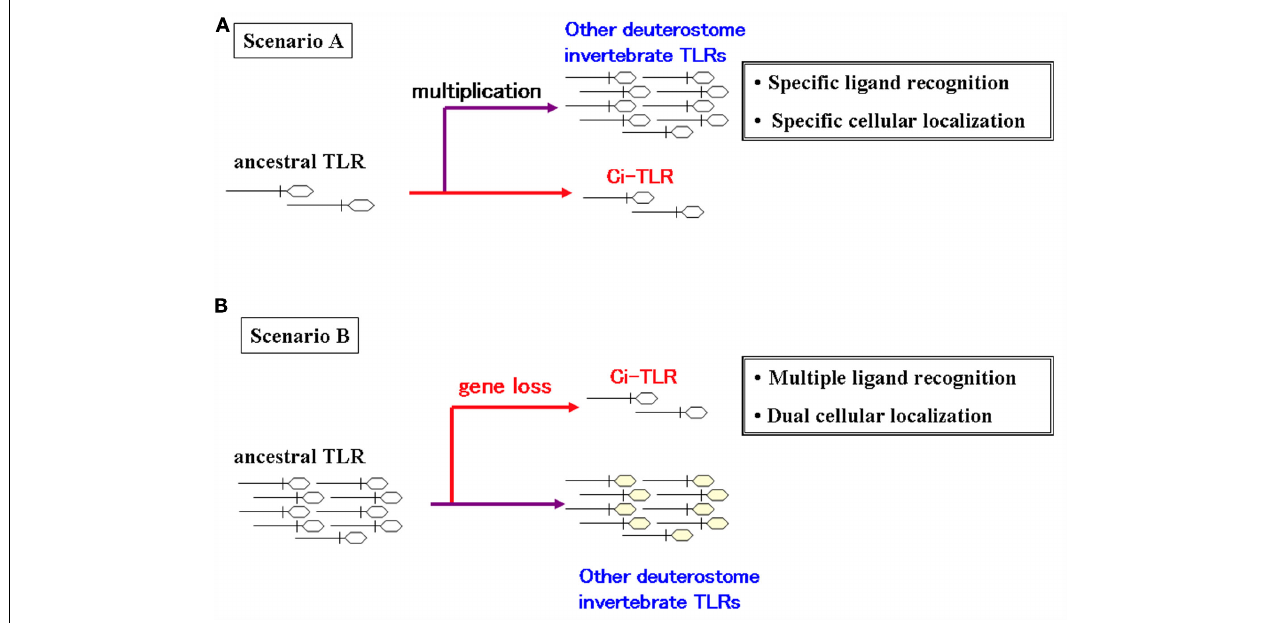
FIGURE 2 | Possible evolutionary scenarios of deuterostome invertebrateTLRs. (A) only a fewTLRs or their related genes might have existed in a common deuterostome ancestor or (B) a common deuterostome ancestor might have numerousTLR family